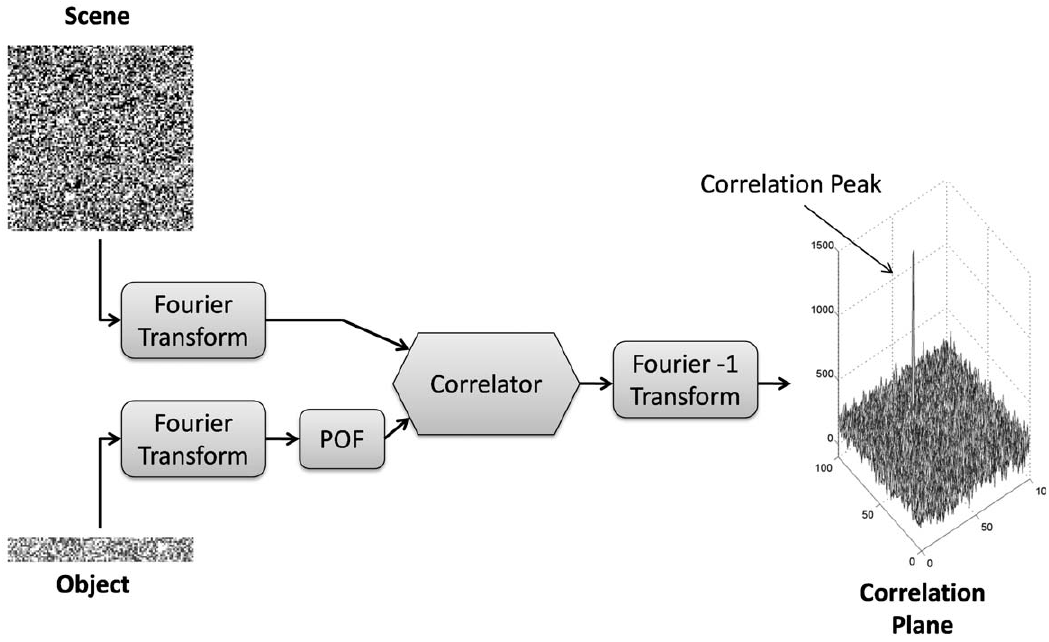
Figure 6. Correlation Process. The scene and object images are Fourier transformed. The object is filtered. Both Fourier Transforms are correlated. The peak indicates matching.